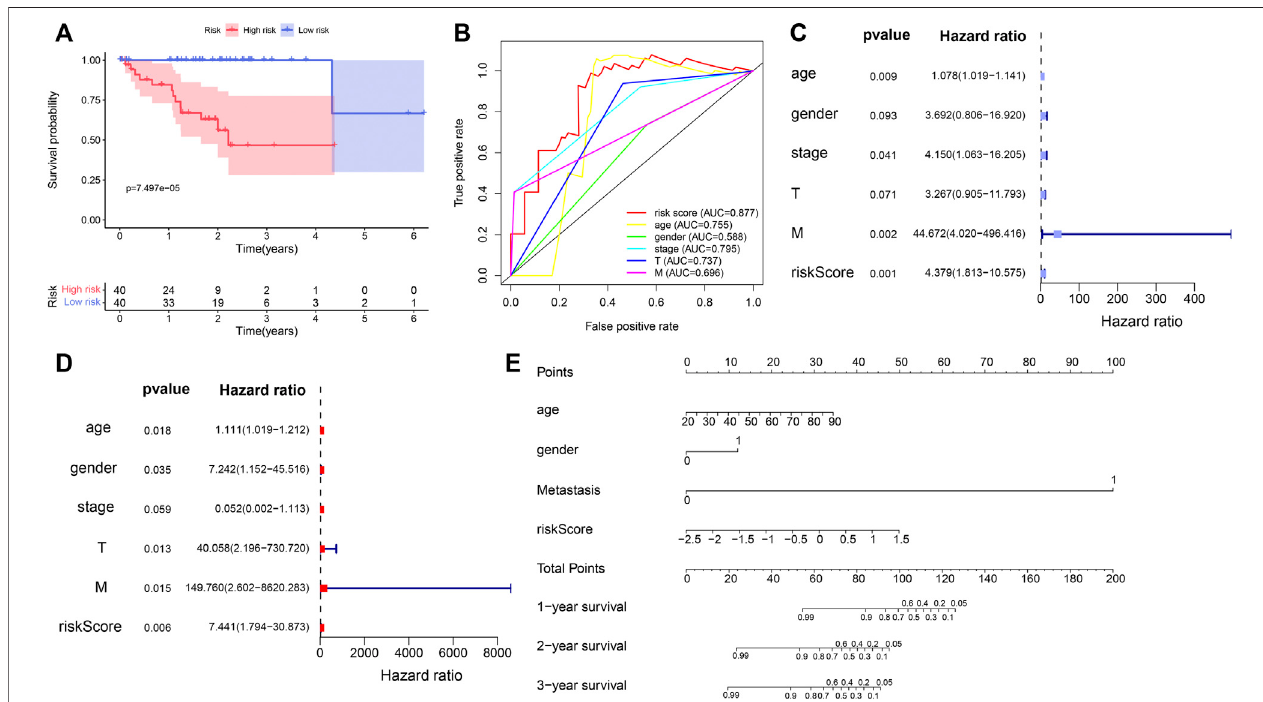
FIGURE6| Evaluationofprognosticvalueofthe fi veimmune-relatedgenesignatureintheTCGA_UVMset. (A) Kaplan – MeiercurveofUVMpatientsinthelow-and high-risk groups of TCGA_UVM cohort. (B) ROC curves with calculated AUCs of the fi ve immune-related gene signature. (C) Univariate cox analysis indicated that age ( p = 0.009), stage ( p = 0.041), metastasis ( p = 0.002) and risk score ( < 0.001) were associated with the UVM prognosis. (D) Multivariate Cox analysis showed that risk score was con fi rmed as independent OS-related factor ( p = 0.006). (E) The nomogram for the prediction of survival probability of UVM patients.